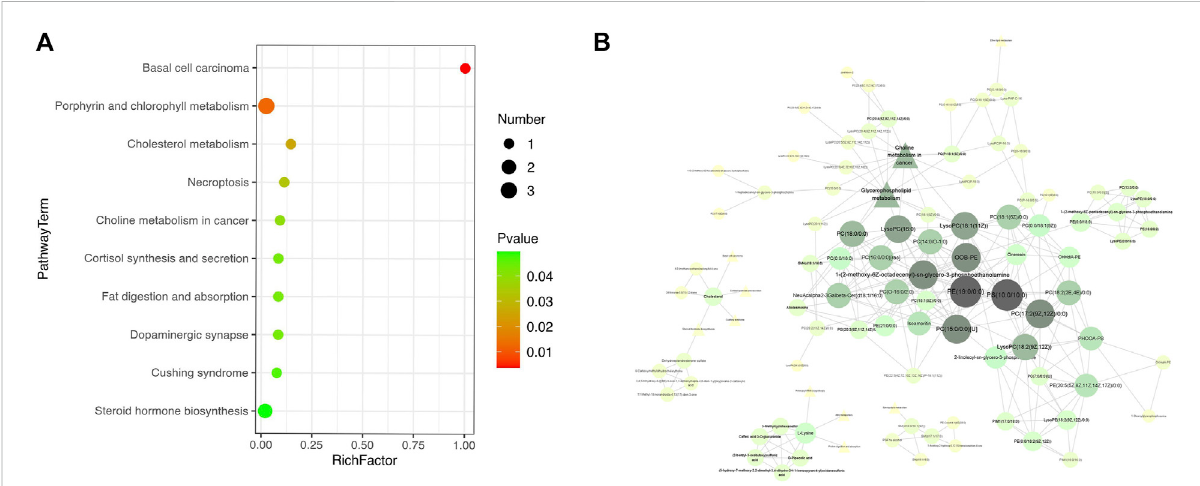
FIGURE 4 Pathway analysis was used to enrich the metabolic pathways of differential metabolites start- and end- LS treatment. (A) KEGG pathway showing the differential metabolic pathways in start- and end- LS groups. (B) Correlation analysis of serum metabolites with signi fi cantly difference. Only metabolite correlations with |PCC| ≥ 0.9 was considered. Circle indicated metabolites and triangles indicated metabolic pathways, with darker colors indicating higher